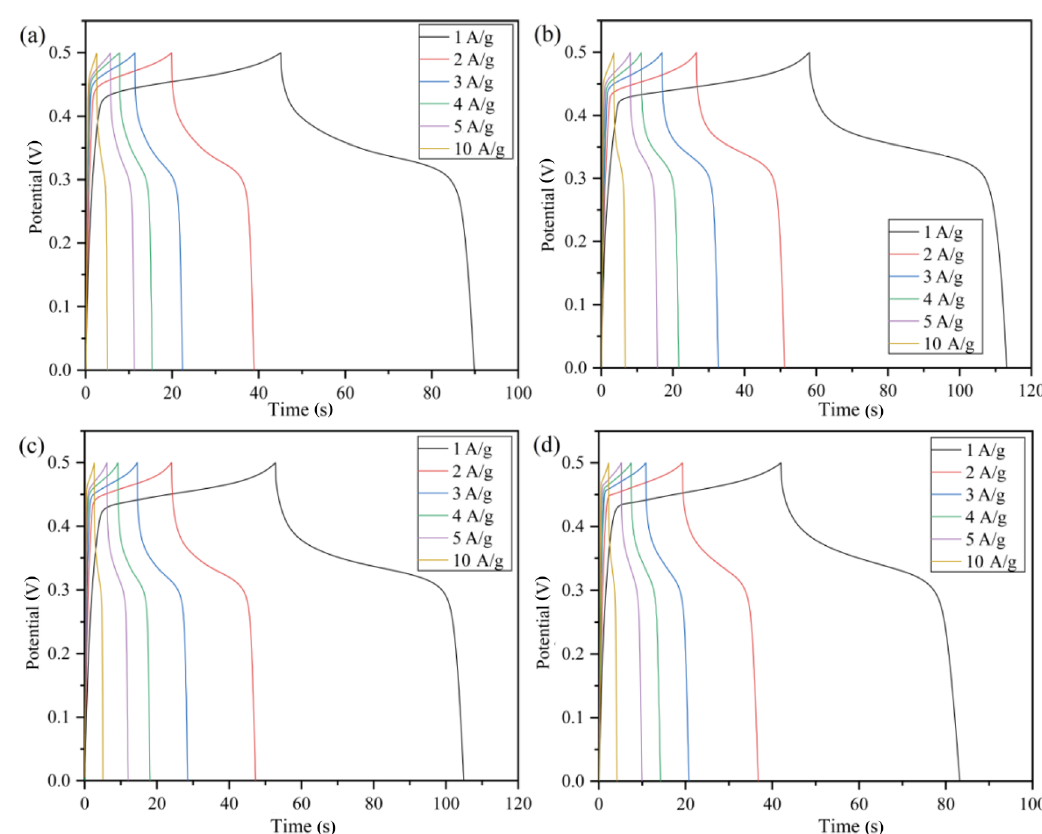
Fig. 7 GCD curves of La(CoCrFeMnNiAl x ) 1/(5+ x ) O 3 − δ : (a) x = 0.4, (b) x = 0.5, (c) x = 0.6, and (d) x = 0.7.